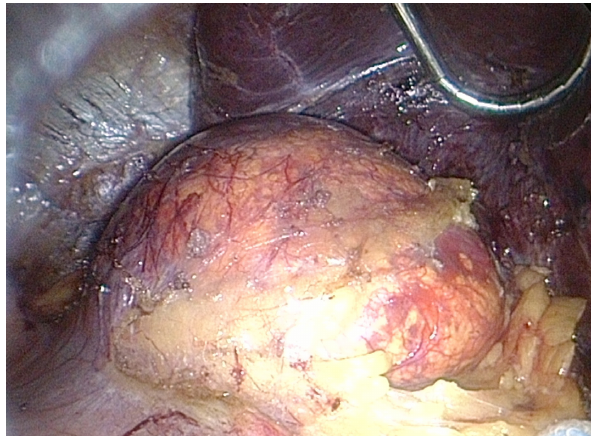
Figure 1: Right incidental adrenal tumor - angiomiolipoma. Intraope- rative